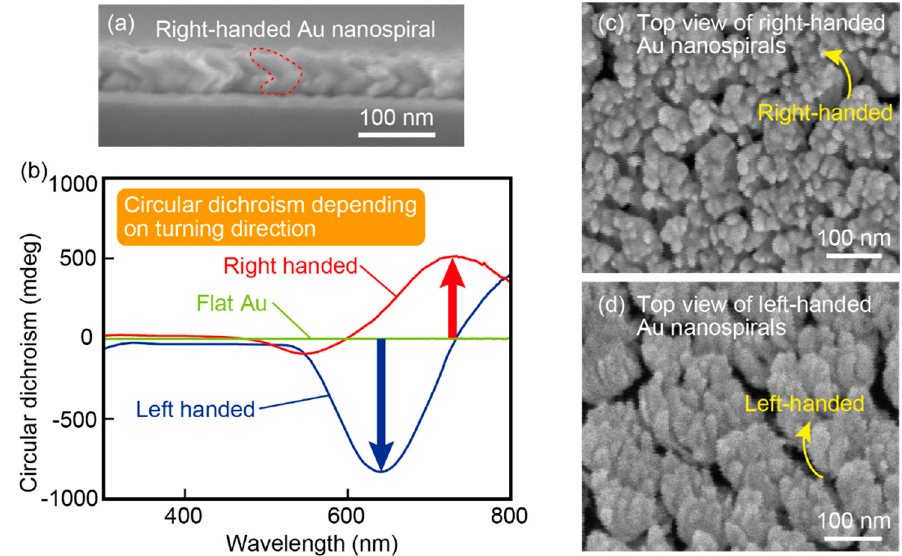
Figure 7. The Au nanospirals with reverse winding directions had opposite polarity circular dichroism to each other, meaning that the filter has chirality. ( a ) SEM image of a side view of the right-handed Au nanospiral structures with a diameter of 50 nm on a Si substrate. ( b ) Circular dichroism spectra of the right- and left-handed Au nanospiral structures and a flat Au film. ( c ) SEM image of a top view of the right-handed Au nanospiral structures. ( d ) SEM image of a top view of the left-handed Au nanospiral structures.